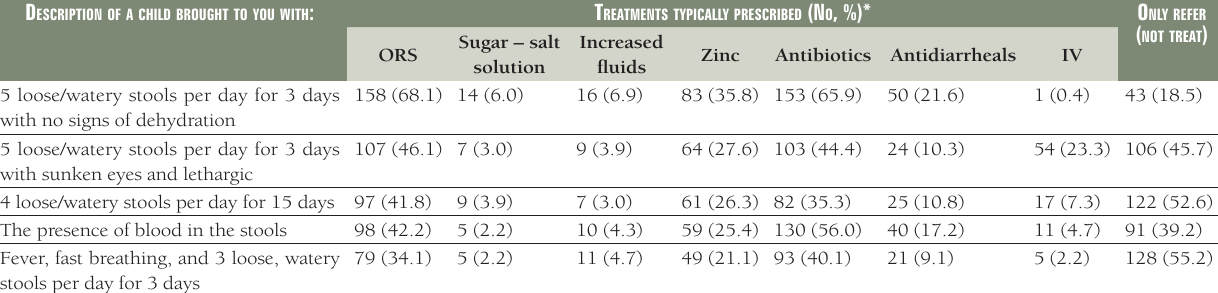
Table 2. Treatment practices reported by private providers in interview (n =